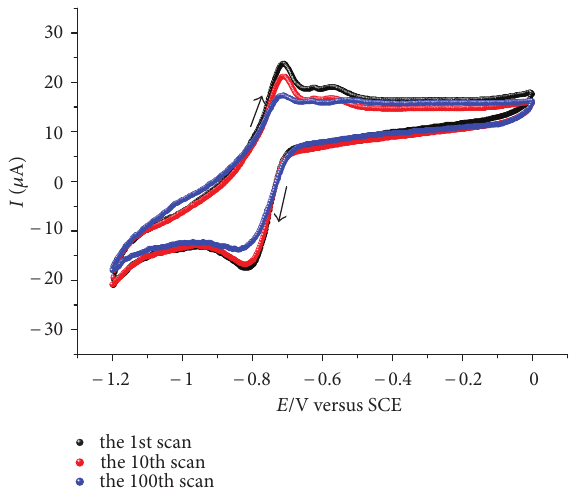
F6:CVsforORRonthebareGC,MWCNTs/GC,MHAQ/GC, - and MHAQ/MWCNTs nanohybrid modi�ed GC electrodes in pH . e CV curves 7.0 O -saturated solutions. Scan rate: 2 −1